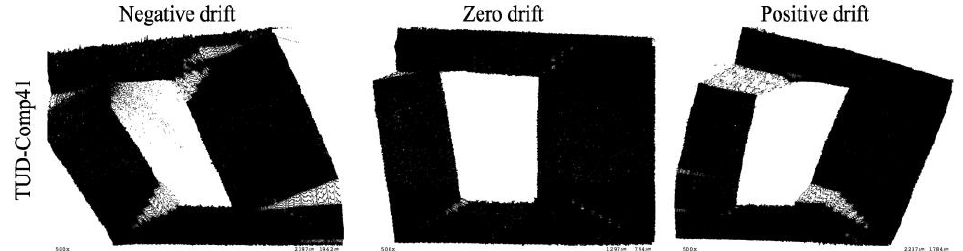
Figure 9. Deformed shape, magnified 500 times, of the unstrengthened wall (TUD-Comp41) resulting from the SLS protocol at a displacement of 2.125 mm (0.085% drift) [5].